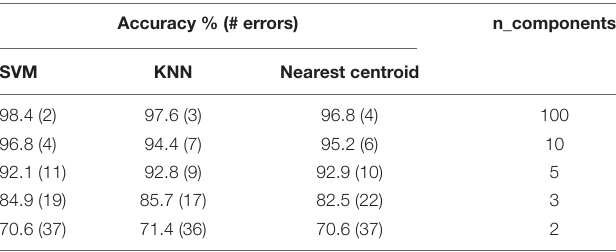
The classification accuracy is the ratio between the number of correctly classified words and the total number of words in the test dataset (of 126